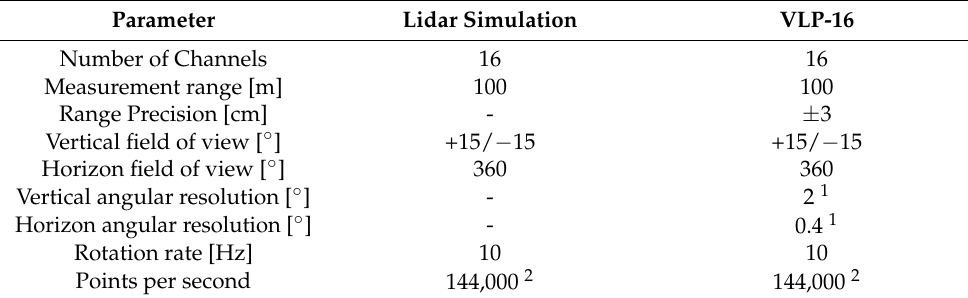
Table 1. Simulated and manufacturer VLP-16 lidar